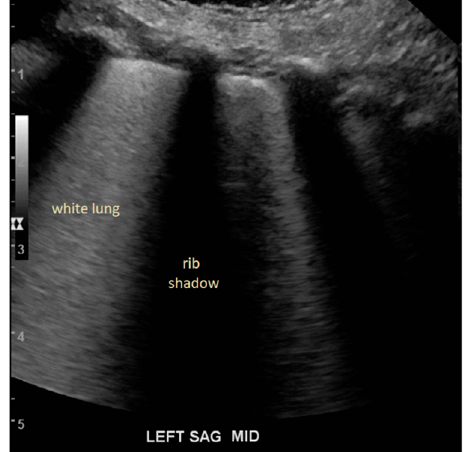
Figure 2. Sonographic image of the lung during static PFC administration in infants showing white lung between the rib shadows without the visualization of lung structure and absence of A-lines. (With permission from Degnan et al. [19]). Table 1. Summary of published values for speed of sound, impedance as well as attenuation ( A f n )